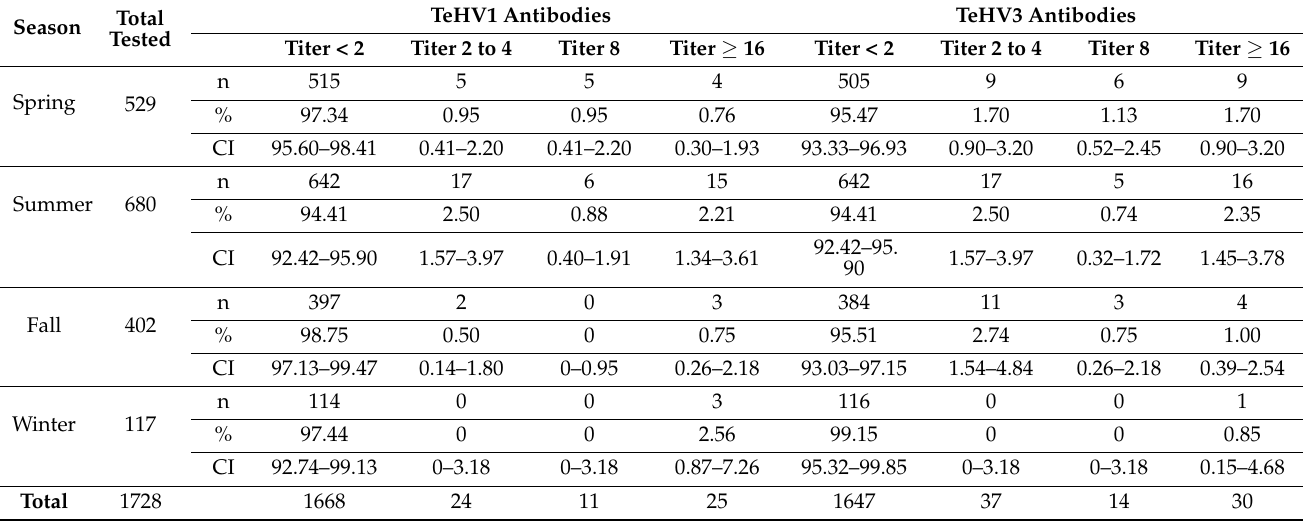
Table 3. Detection rates of antibodies against testudinid herpesvirus 1 (TeHV1) and testudinid herpesvirus 3 (TeHV3) depending on season of sampling. Results shown as: number, percent, 95% confidence interval